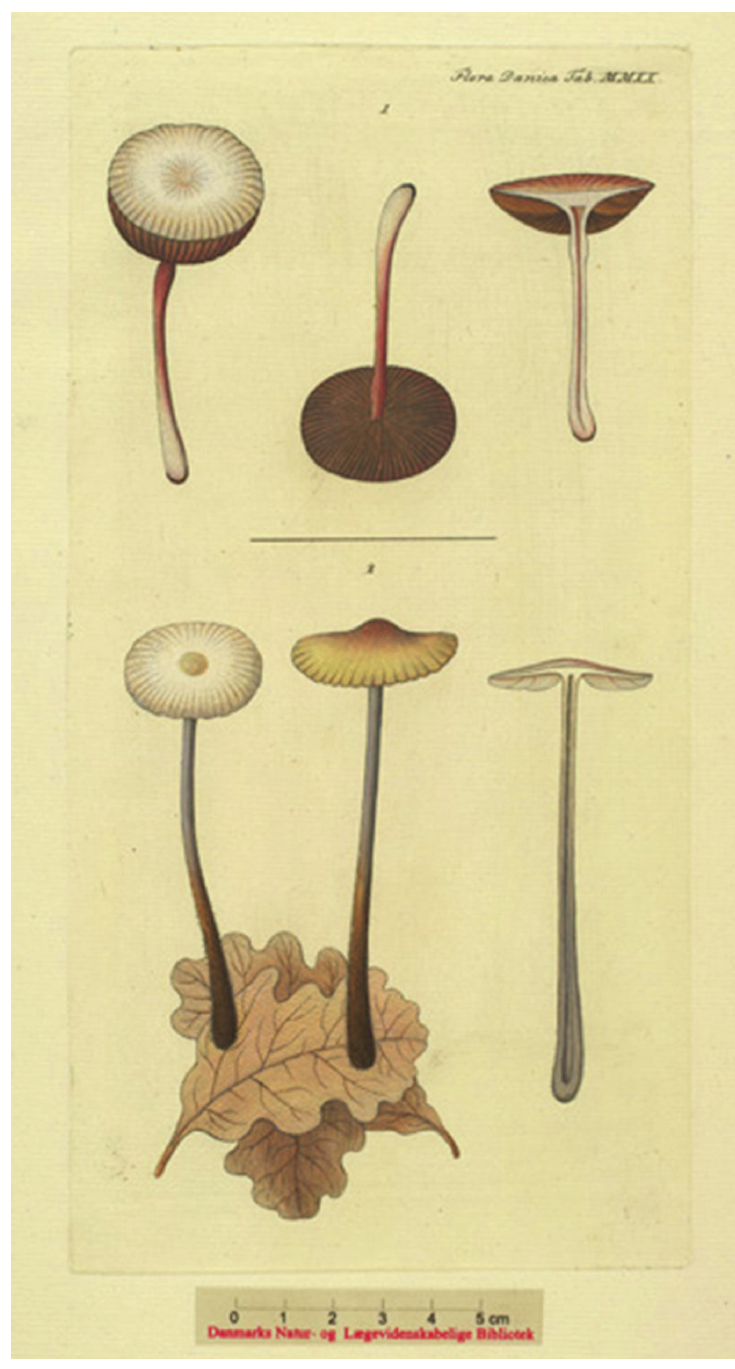
Figure 94. Plate 2020 from Flora